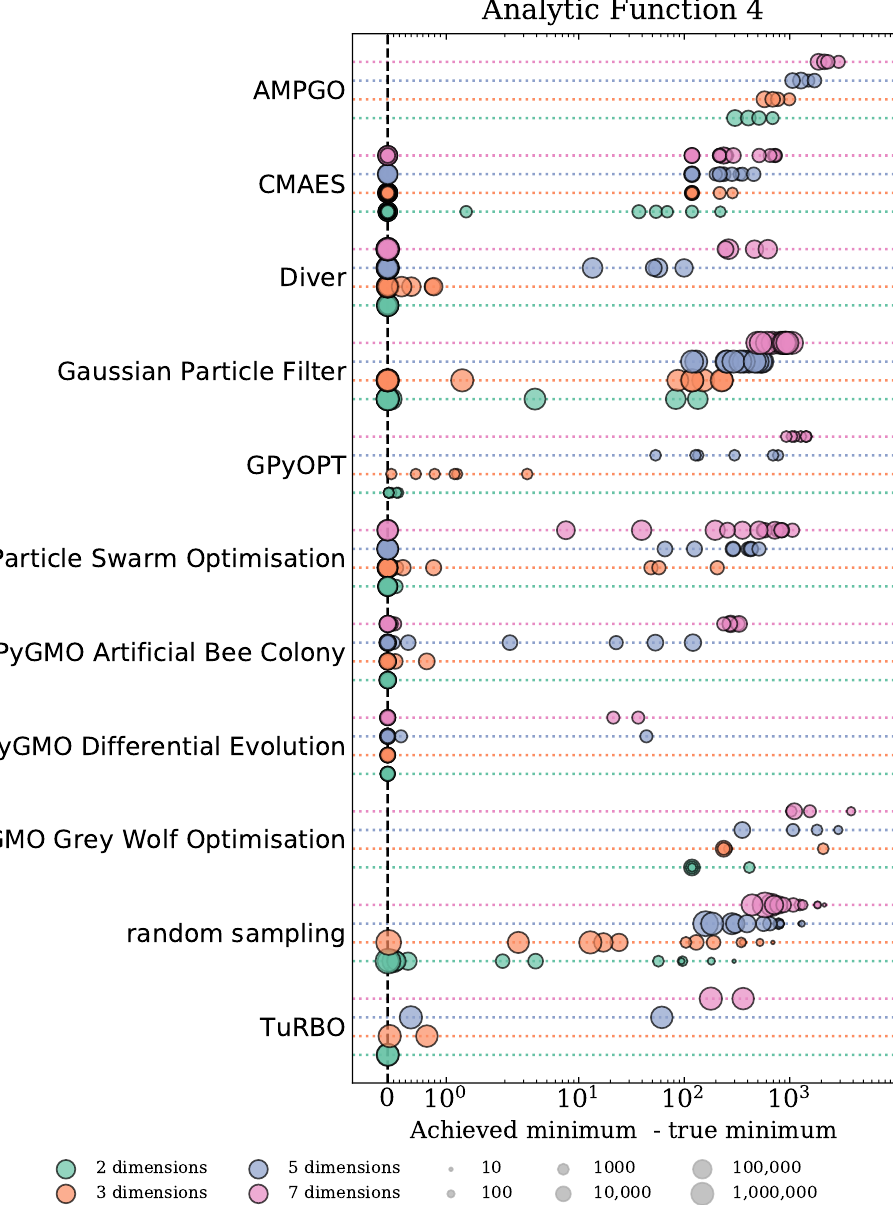
Figure 7. Results from different optimisation algorithms on the analytic function in equation (3.4). The results are shown as semi-opaque circles, of which the area increases logarithmically with the number of function evaluations needed to obtain that specific result. The four horizontal lines for each algorithm belong to the four explored dimensionalities, from top to bottom 7-dimensional (pink), 5-dimensional (purple), 3-dimensional (orange) and 2-dimensional (green). The horizontal axis shows the difference between the (known) log-likelihood at the global minimum and that at the found